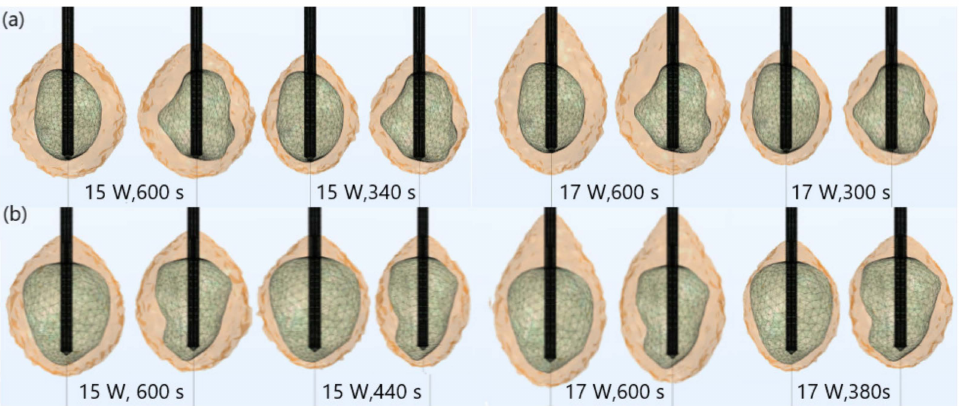
Figure 4. Iso-contours consisting of totally ablated regions (solid light brown surface) and tumors (triangulated surface) ( a ) 1.07 [51] and ( b ) 1.03 [51] exposed to a frequency of 2.45 GHz, an input power of 15 W and 17 W for various ablation